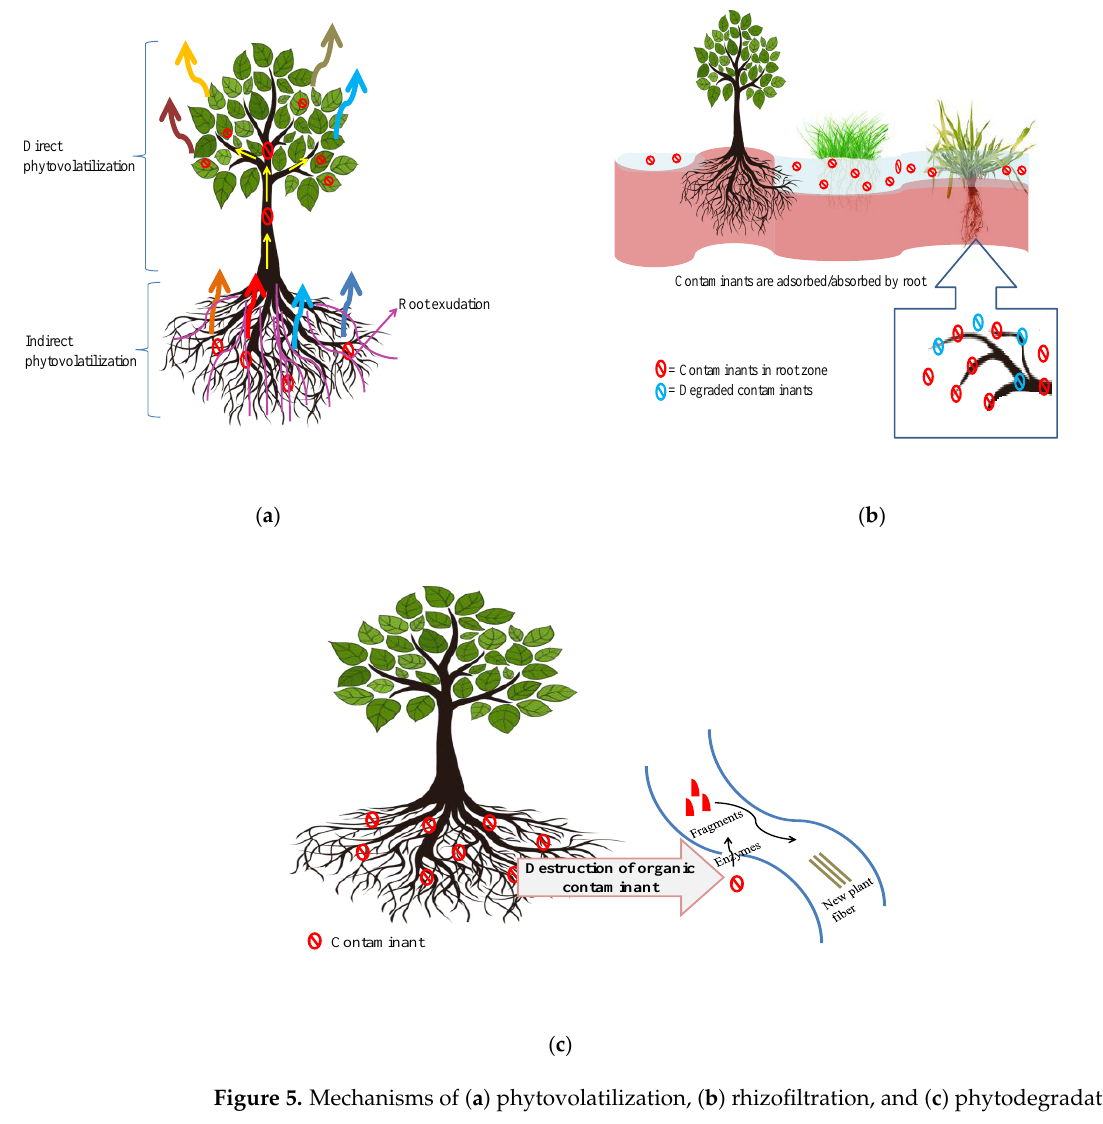
Figure 5. Mechanisms of ( a ) phytovolatilization, ( b ) rhizofiltration, and ( c ) phytodegradation.